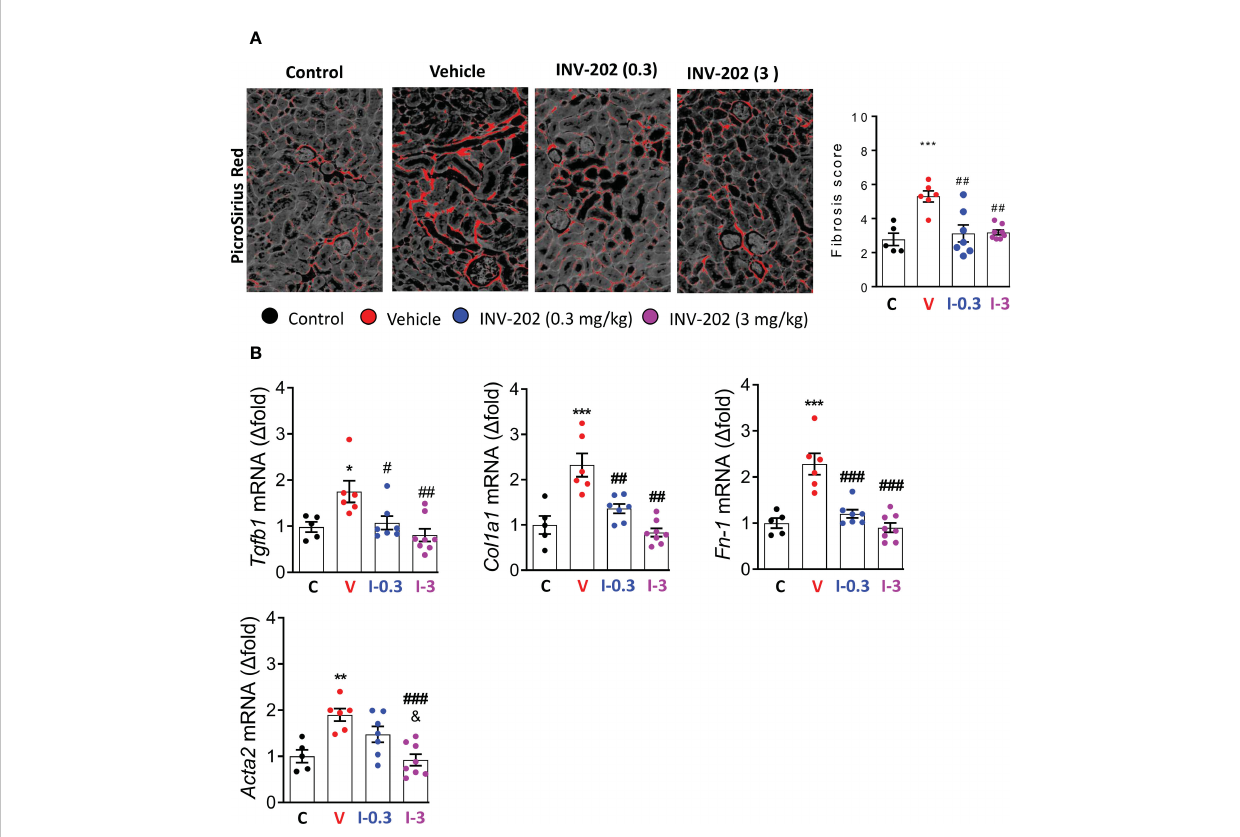
FIGURE 6 INV-202 reduces renal fi brosis. (A) Representative picro-sirius red stains of kidney slides for collagen fi bers with analysis of mean fi brosis scores. (B) mRNA analysis of Tgfb1, Col1a1, Fn-1 and Acta2 coding for TGF- b , Collagen I type 1, fi bronectin and a -smooth muscle actin respectively. Statistical signi fi cance versus the standard condition: *p < 0.05; **p < 0.01; ***p < 0.001; versus vehicle: #p < 0.05; ##p < 0.01; ###p < 0.001; versus INV-202 group. C: non-diabetic control mice, V: Vehicle-treated diabetic mice, I-0.3: INV-202-treated diabetic mice (0.3 mg/kg), I-3: INV- 202-treated diabetic mice (3